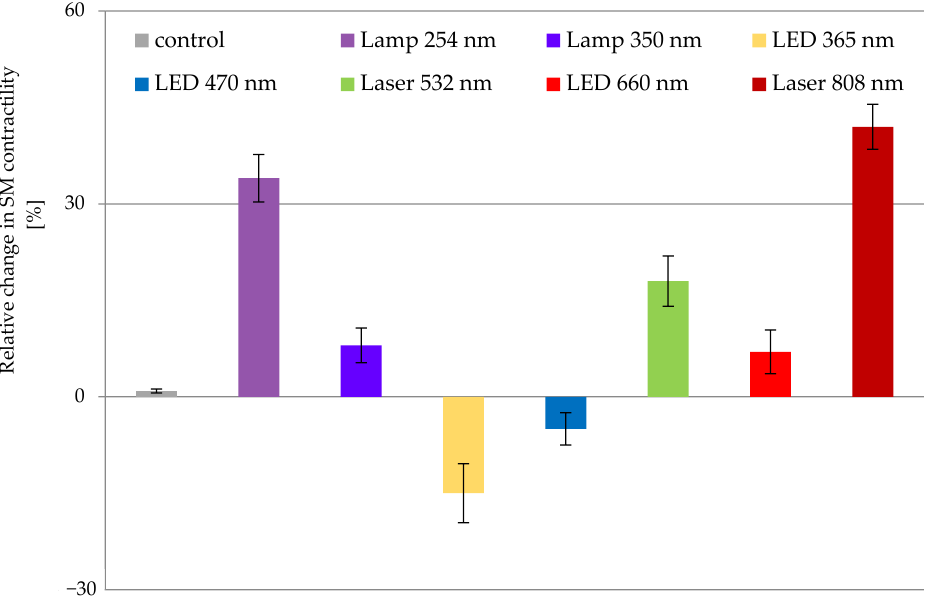
Figure 2. SM contractility after in vitro irradiation of the SMT with different light sources. SMT were irradiated in WOB conditions with varying ER sources for 60 s. The reactivity to 5-HT at the concentration of 5 µ M was recorded on the 15th min post irradiation. The relative changes in the SM contractility are presented as percentages and represent MEAN ± STDV measurements from n = 7 tissues. The comparison was conducted between the SCA of the irradiated SMT and control ones after the exogenous application of 5-HT. Statistical significance was accepted at p < 0.05.